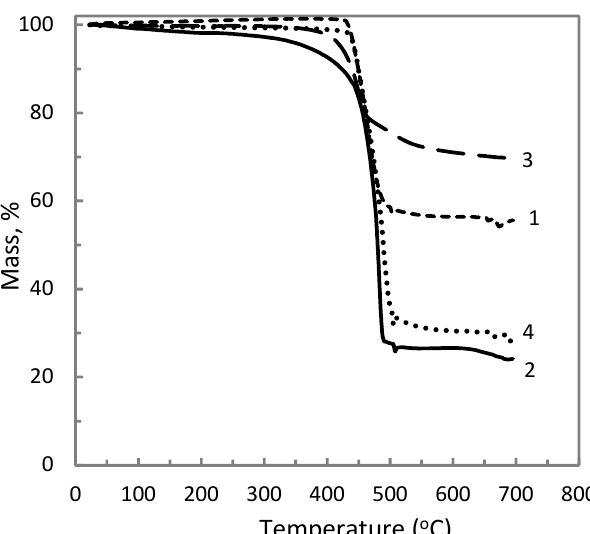
Figure 7. Thermogravimetric curves of ETFE/AP/MK/TiO 2 composites with the following compo- sitions: 40/30/30/0 (1), 60/20/20/0 (2), 55/0/45/0 (3), and 65/0/0/35 (4) (wt %). Table 3. Heat resistance of the composites depending on the content of inorganic components. ETFE/AP/MK Composition (wt %).